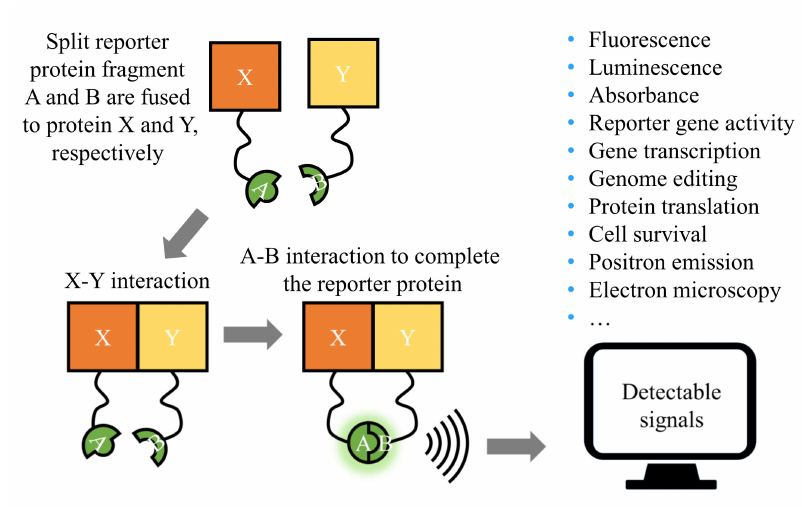
Figure 7. Illustration of protein fragment complementation assays (PCAs). The engineered split reporter protein fragments A and B are fused to proteins X and Y, respectively. Upon interaction of proteins X and Y, fragments A and B noncovalently bind to form a complete reporter protein that can produce detectable signals, such as